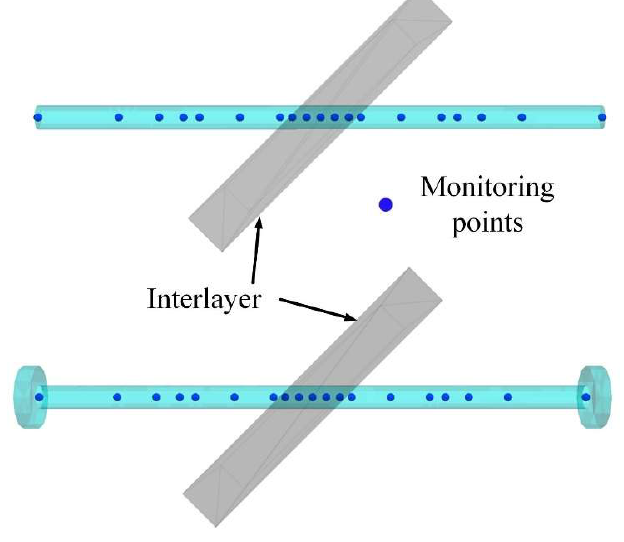
Figure 20. Monitoring-point arrangement for anchor.